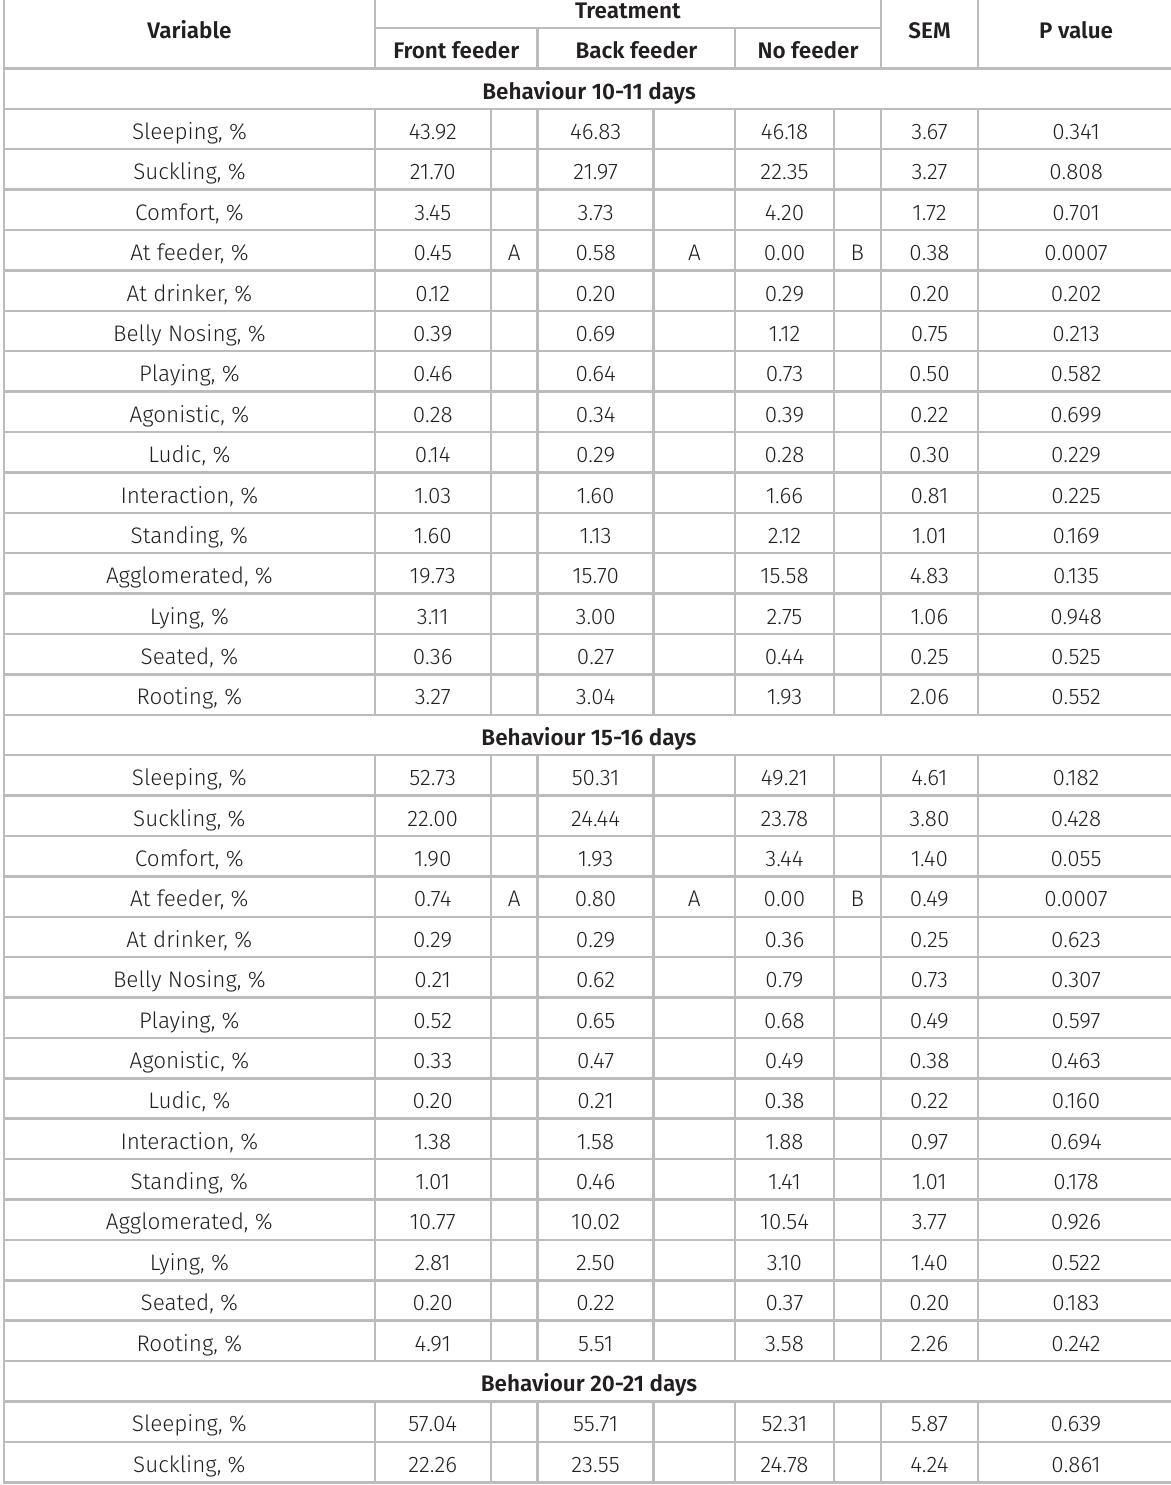
Table II. Piglets behaviour at 10-11, 15-16, and 20-21 days after farrowing with different positions of piglet feeder on the farrowing crate or without piglet